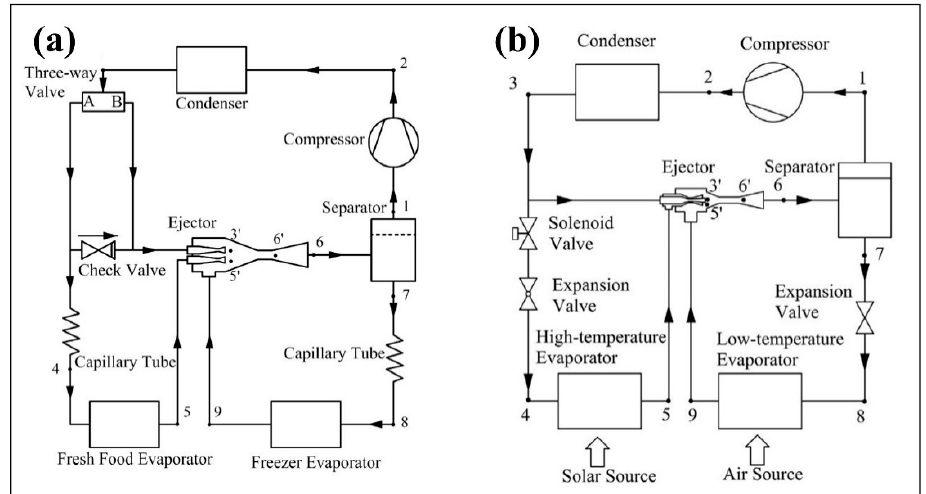
Figure 13. Multi-evaporator cycles with dual-nozzle ejector: ( a ) Zhou cycle [43]; ( b ) Zhu cycle [179].